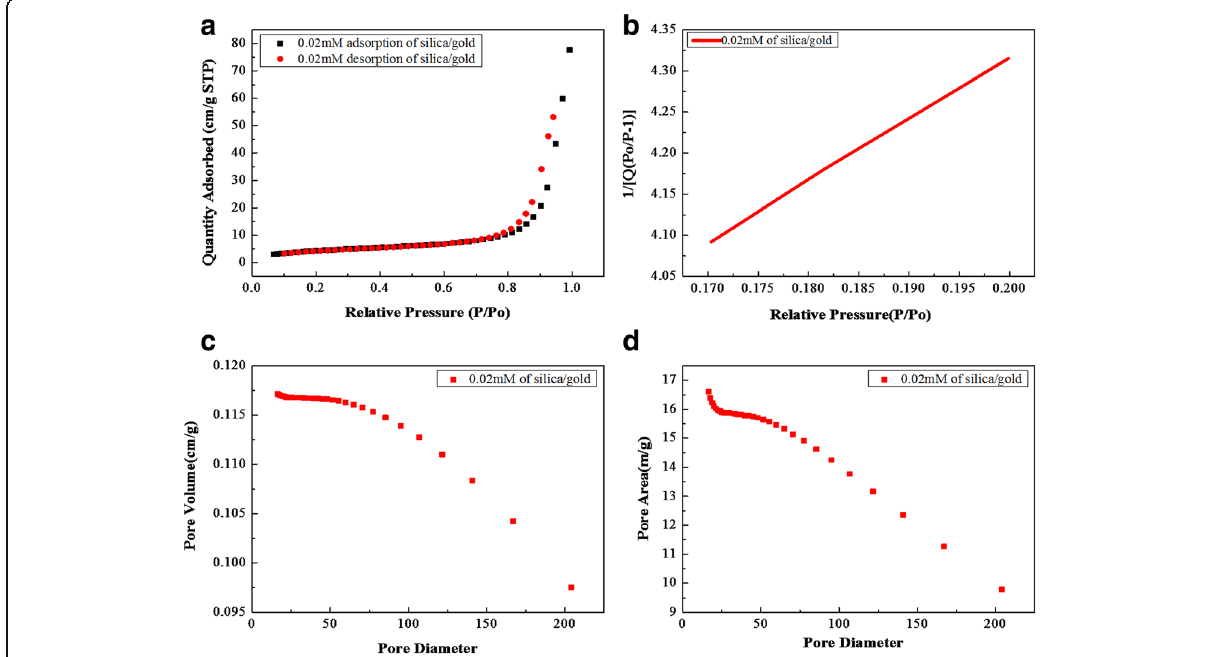
Fig. 11 (a-d) BET results of cellulose-amino POSS hybrid composite by sol-gel process